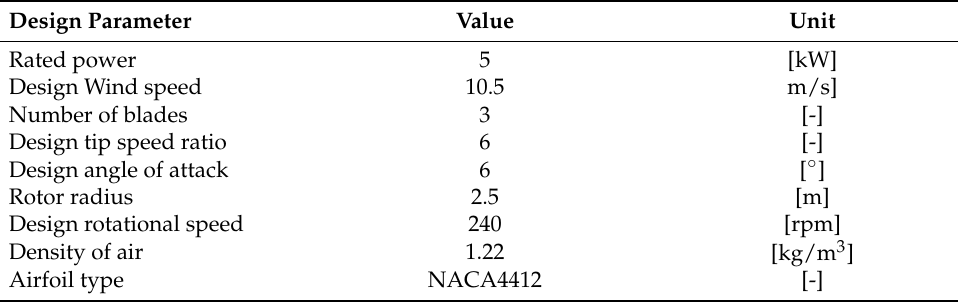
Figure 2. Airfoil section with aerodynamic loads. Table 1. Initial design parameters of 5 kW small wind